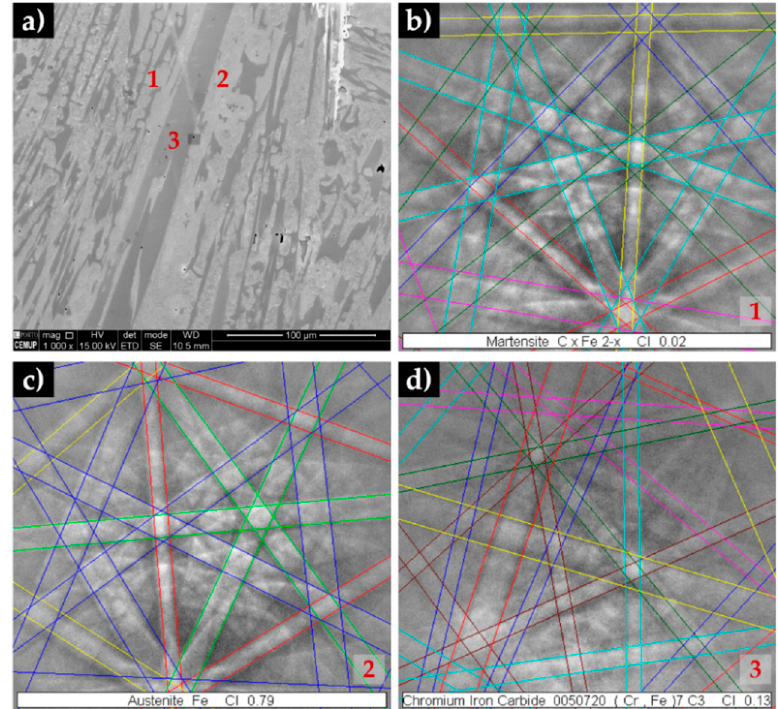
Figure 9. SEM-SE image of the base metal in the as-cast condition ( a ), and indexed EBSD patterns corresponding to the phases that compose the microstructure: α ’ ( b ), γ ( c ) and M 7 C 3 ( d ).